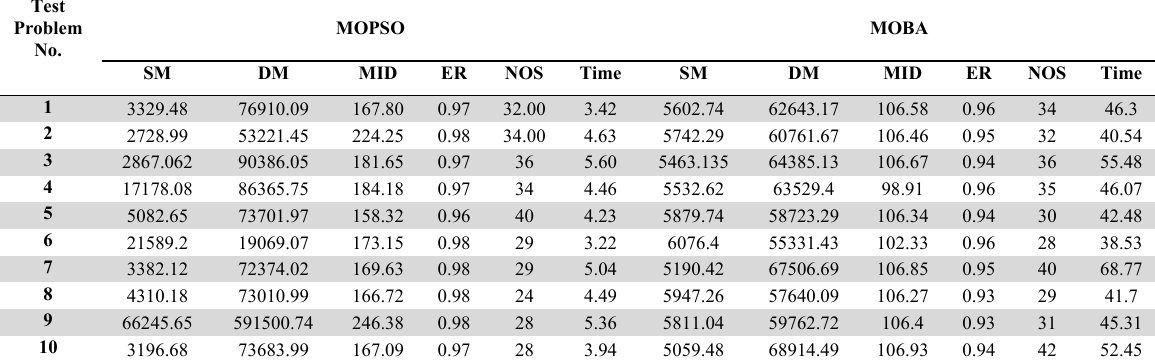
Experimental results of six metrics in WIP inventory model